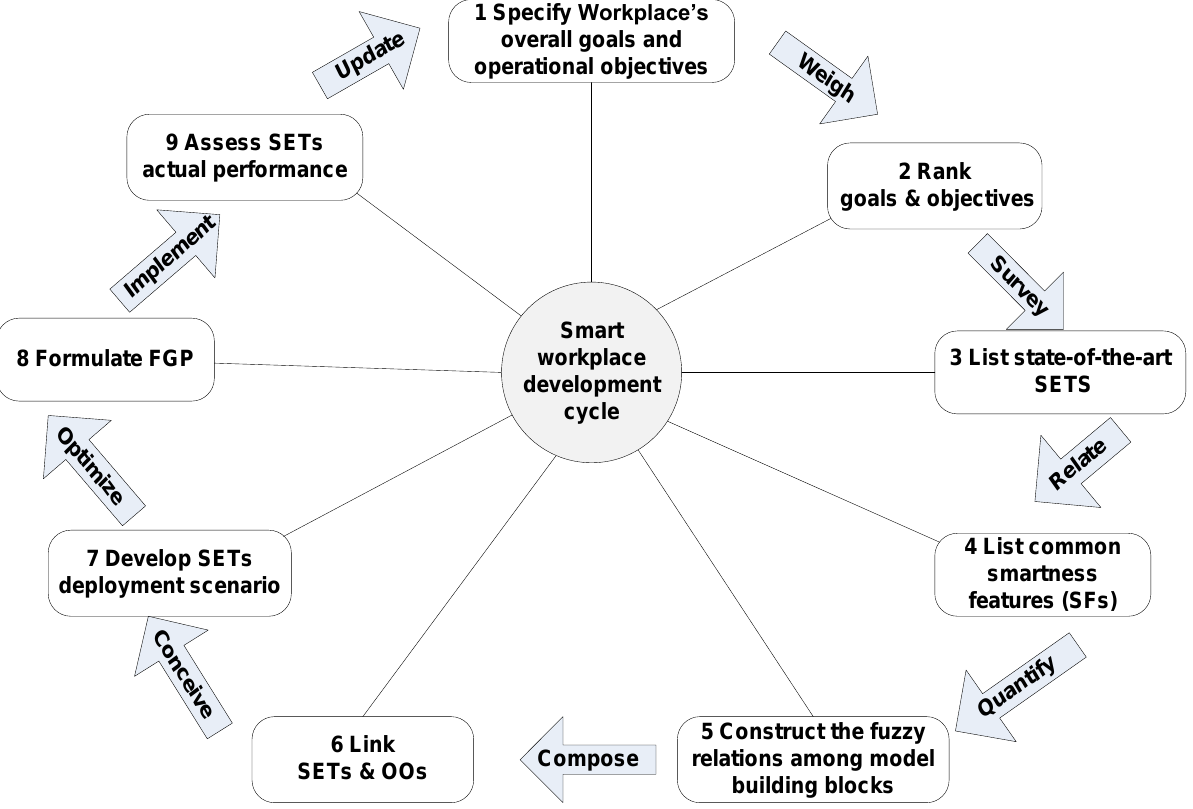
Figure 1. Smart workplace design procedure.